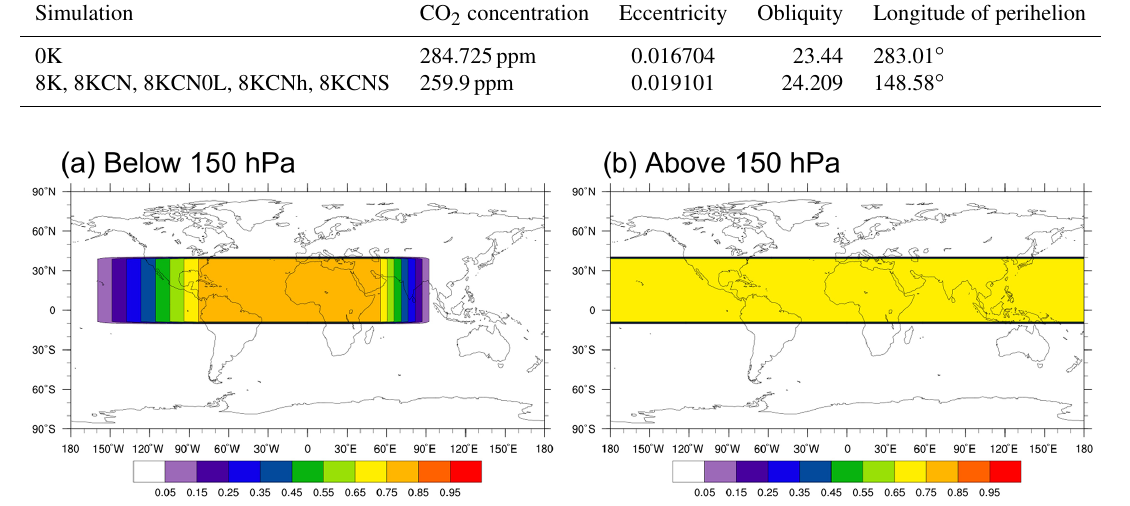
Figure 2. Dust reduction fraction (a) below 150hPa and (b) above 150hPa in the 8K experiments compared to the present-day values.